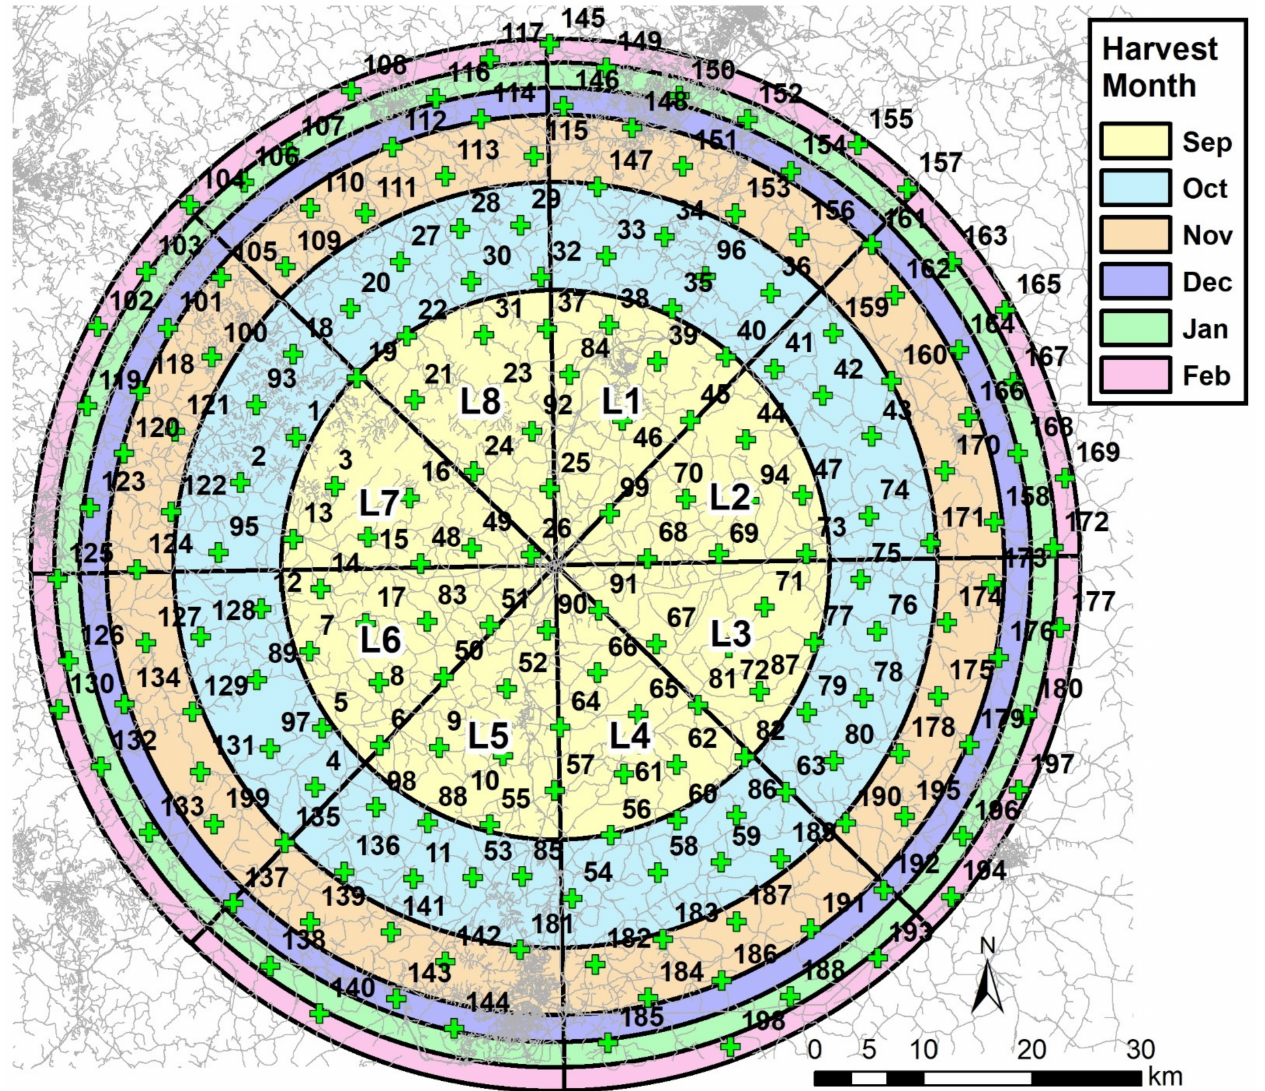
Figure 2. Assignment of load-out sequences (L1 to L8) for the subareas in the eight-load-out-operation simulation for the 199 SSLs in the Gretna